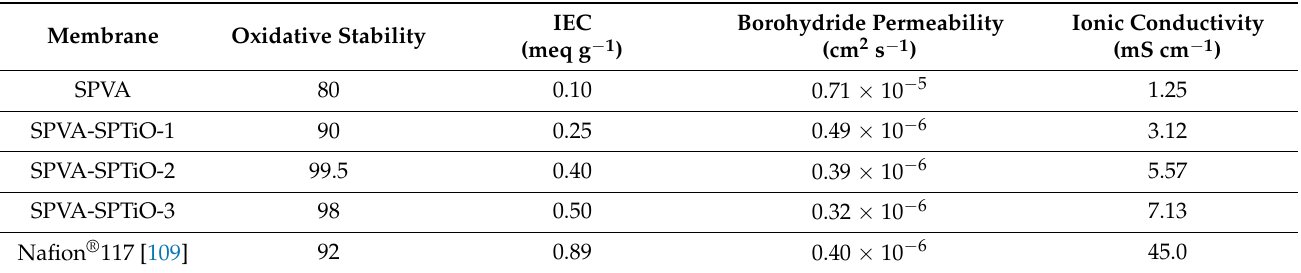
Figure 7. Cell voltage and power density vs. current density for PC-PVA/s-TiO 2 -II hybrid membrane [99]. PC-PVA/s-TiO 2 = pectin-poly(vinyl alcohol)/sulfonated titanium dioxide. Reproduced with permission from Elsevier. Table 2. Properties of fabricated fuel cell membranes in comparison with Nafion ® 117 [108]. SPVA = sulfonated poly(vinyl alcohol); SPTiO 2 = SO 4 - and PO 4 -doped titania nanotubes. Reproduced with permission from